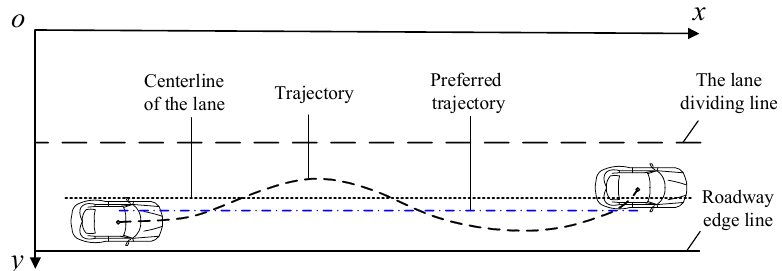
Figure 4. Illustration of feature parameters.